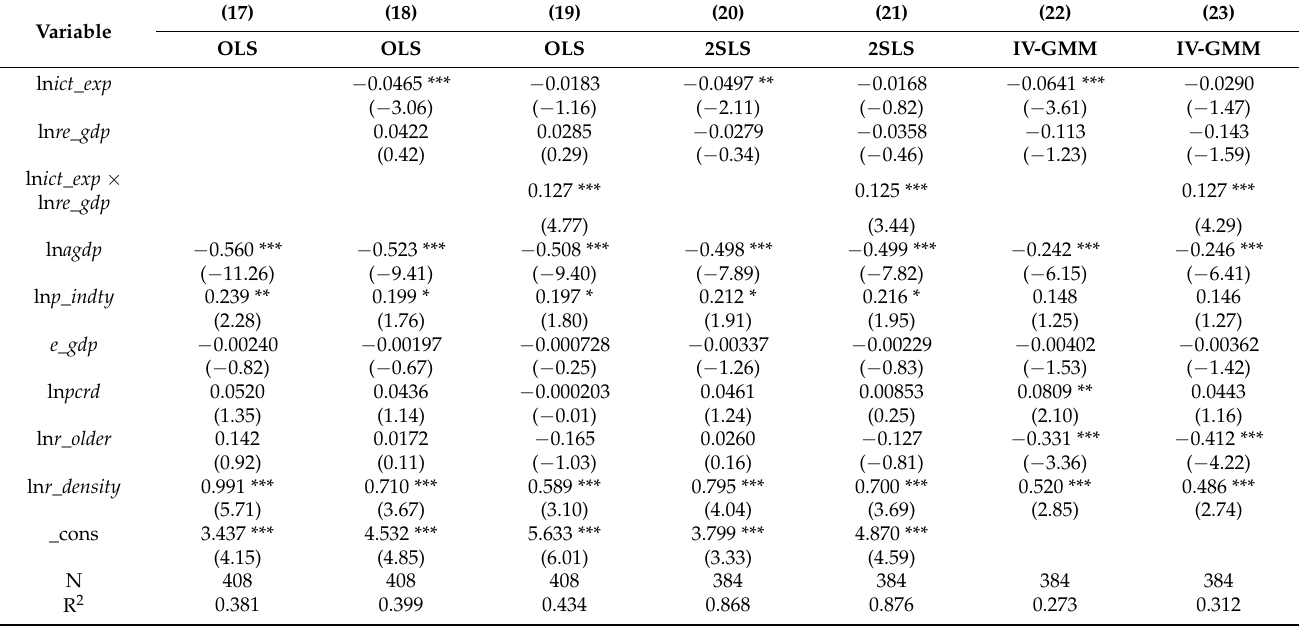
Table 7. Estimated results of resource consumption